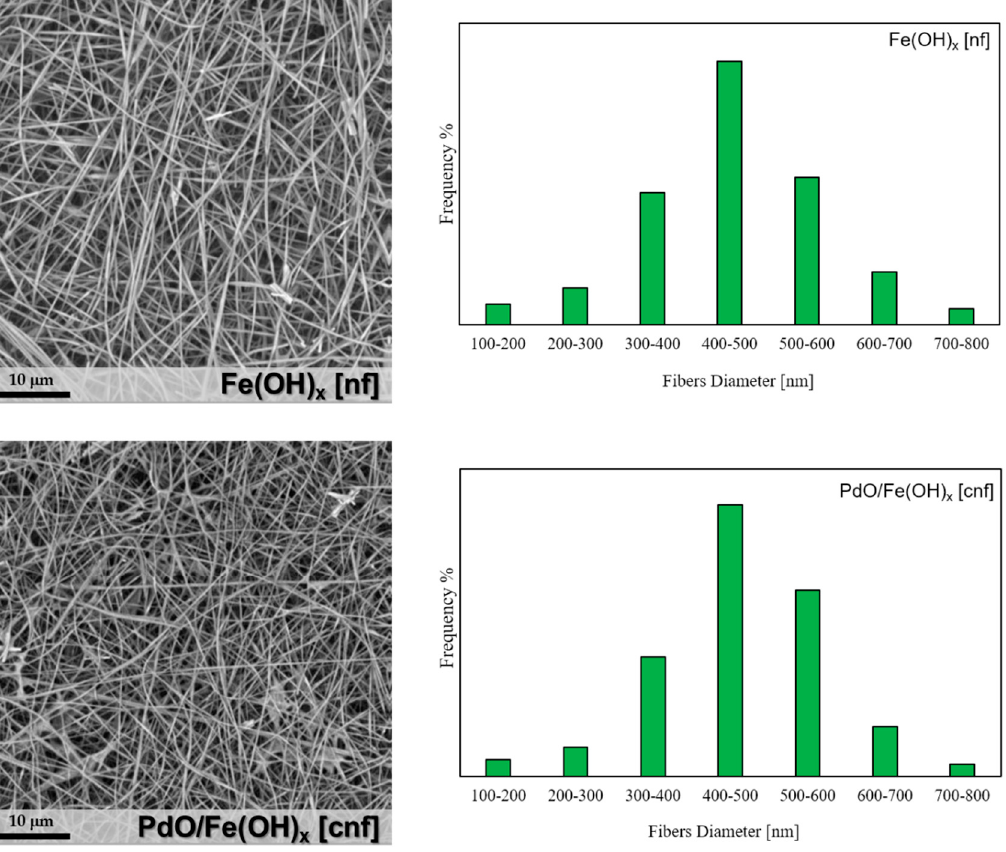
Figure 1. SEM images of as-spun Fe(OH) x [nf] and PdO/Fe(OH) x [cnf] samples, together with their fibers diameter distribution.